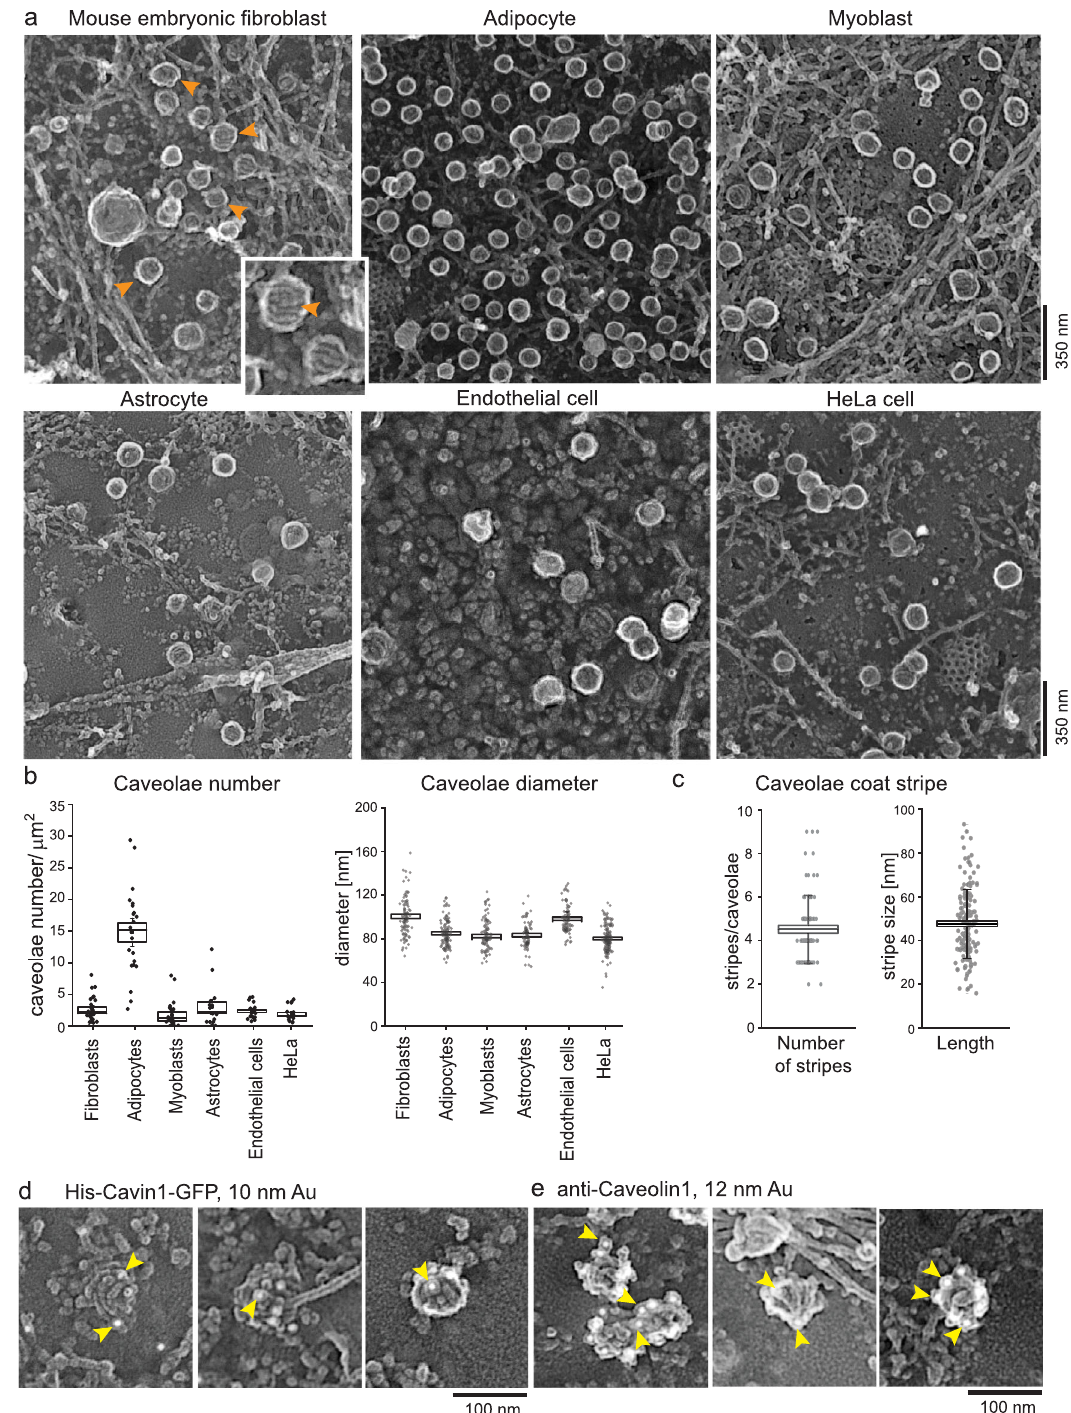
Fig. 1 | Overview of caveolae at the plasma membrane in various cell types. a Representative platinum replica transmission electron microscopy (PREM) ima- gesofplasmamembranesheetsofdifferentcelltypes.Theimagesarepresentedin an inverted scale. Orange arrows indicate individual caveolae. b Caveolae number and diameter were measured in all cell types (n( fi broblasts)=26, n(adipocytes)= 22, n(myoblasts)=22, n(astrocytes)=17, n(endothelial cells)=21, n(HeLa)=19; diameter: n( fi broblasts, MEFs)=82, n(adipocytes)=95, n(myoblasts)=83, n(astro- cytes)=64, n(endothelial cells, HUVEC)=70, n(HeLa)=118, 2 independent